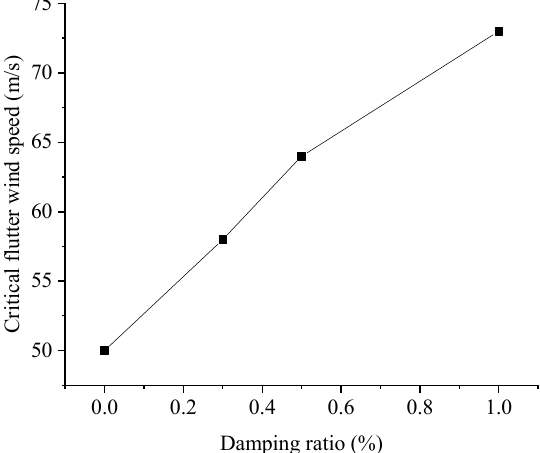
Figure 15. Change curve of flutter critical wind speed with damping ratio.